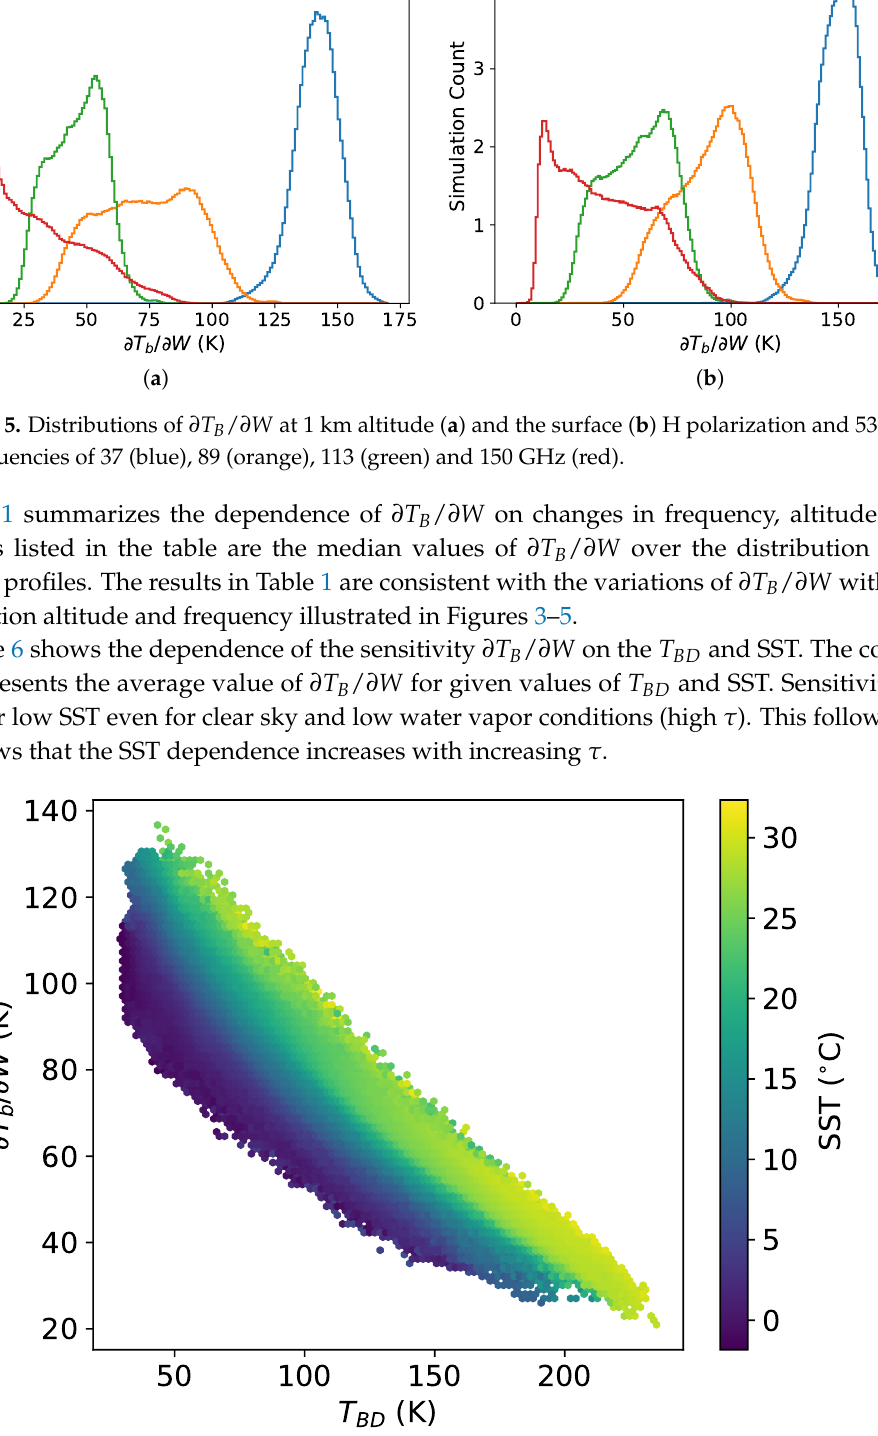
Figure 6. Whitecap fraction sensitivity, ∂ T B / ∂ W , as a function of T BD and SST for 89 GHz H-polarization at 1 km altitude and 53 ◦ EIA. The color represents the average SST for a given two-dimensional bin in T BD and ∂ T B / ∂ W